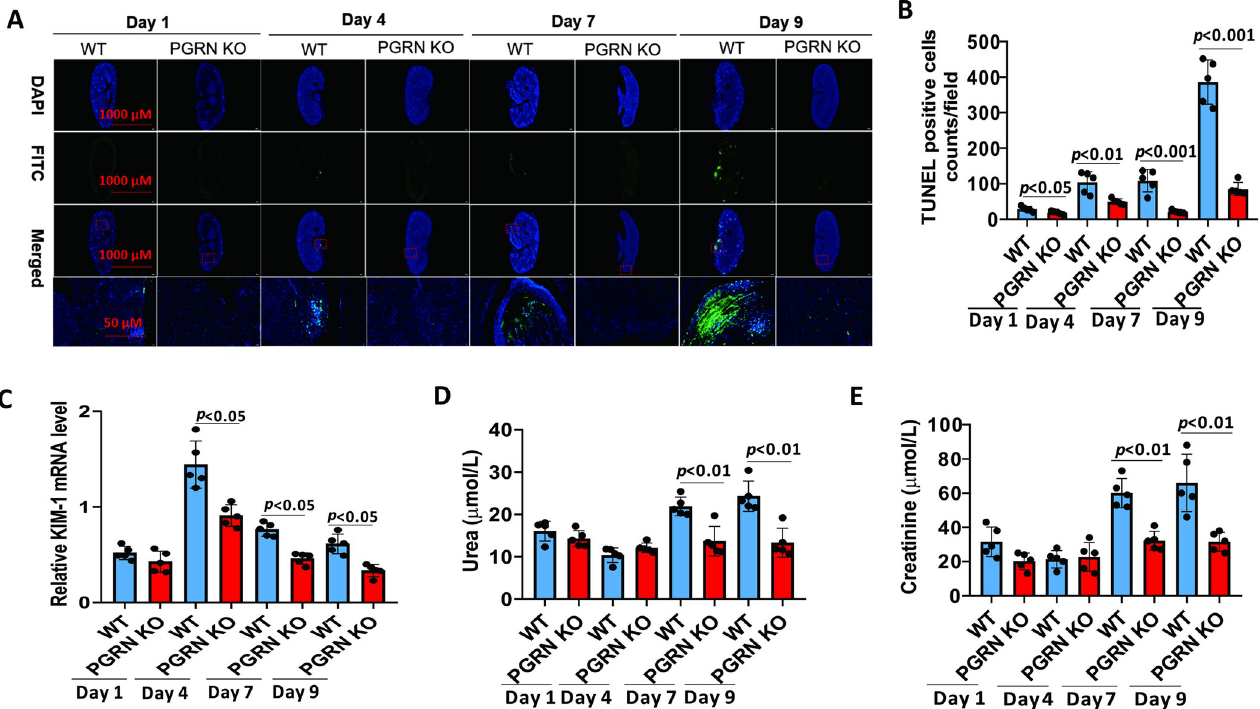
Fig 5. PGRN deletion reduced immune cell apoptosis and tissue injury in the kidneys after invasive C . albicans infection. PGRN KO (n = 5) and WT (n = 5) mice were infected intravenously with 4 × 10 5 colony forming units (CFU) of C . albicans , and then immune cell apoptosis in the kidney and tissue injury markers were assessed at the indicated times. (A) The kidneys from WT (n = 5) and PGRN KO (n = 5) mice at the indicated times after intravenous infection with 4 × 10 5 CFU of C . albicans were subjected to DNA fragmentation analysis (terminal deoxynucleotidyltransferase dUTP nick end labeling [TUNEL]). Representative examples were shown. (B) TUNEL-positive cells were counted (n = 5 per group) at the indicated times after intravenous infection with 4 × 10 5 CFU of C . albicans . (C) Kidney total RNA was analysed for gene expression of kidney injury marker-1 (KIM-1) at the indicated times after intravenous infection with 4 × 10 5 CFU of C . albicans . (D) Serum urea levels in WT (n = 5) and PGRN KO (n = 5) mice after intravenous infection with 4 × 10 5 CFU of C . albicans . (E) Serum creatinine levels in WT (n = 5) and PGRN KO (n = 5) mice after intravenous infection with 4 × 10 5 CFU of C . albicans . All data were pooled from three independent experiments. The Mann–Whitney U test was used to analyze the difference between WT and PGRN KO mice at the same time point after C . albicans infection, and p values were shown when compared between groups denoted by horizontal